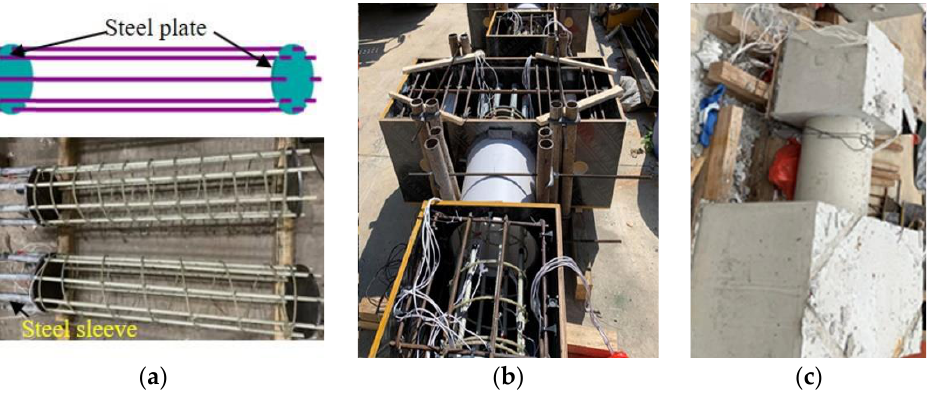
Figure 6. Fabrication of the concrete short columns. ( a ) Positioning of longitudinal bars; ( b ) Before the casting; ( c ) After the casting.